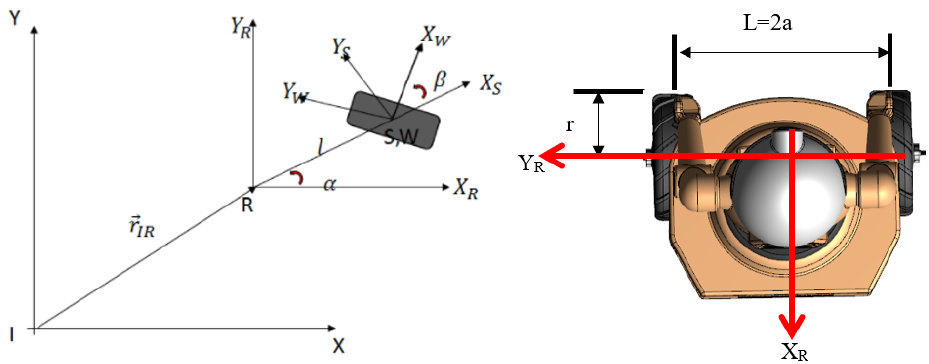
Figure 23. Geometry of two-wheeled differential